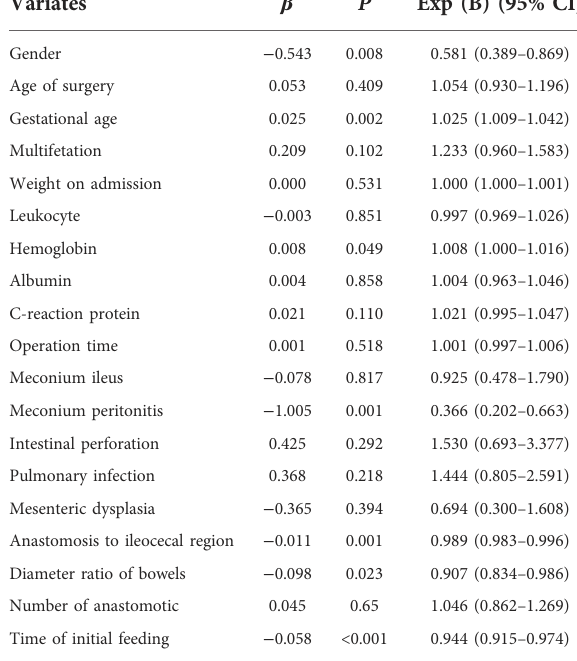
TABLE 2 Univariate cox regression analysis for predicted